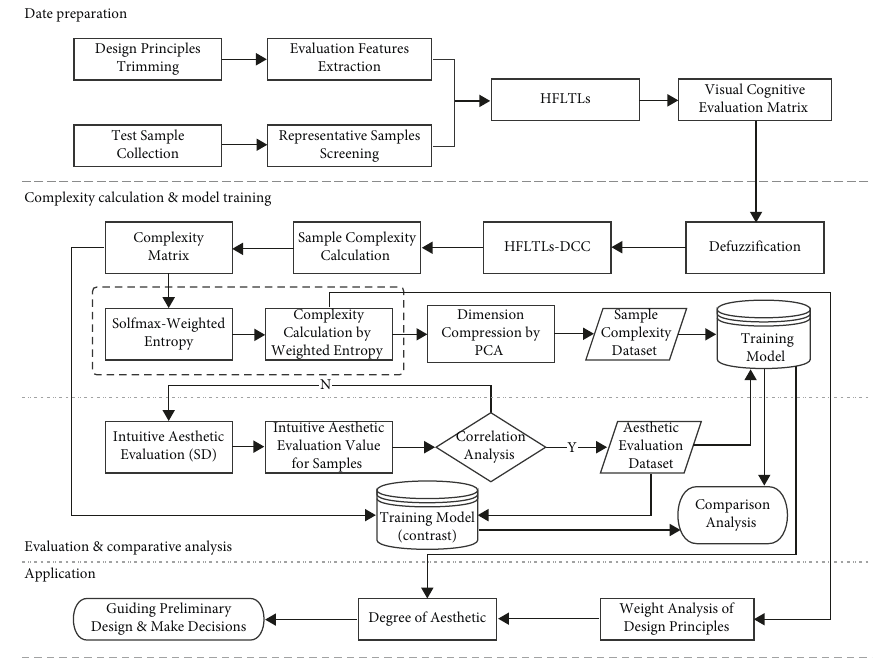
Figure 2: Research route of visual cognitive aesthetic